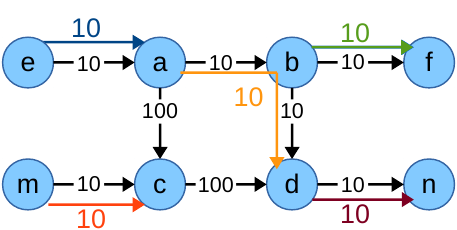
Figure 8. Scenario as in Figure 7, but NFF-objective-II prevents flow [ a,d ] from using multipath although it does not harm any other flow.